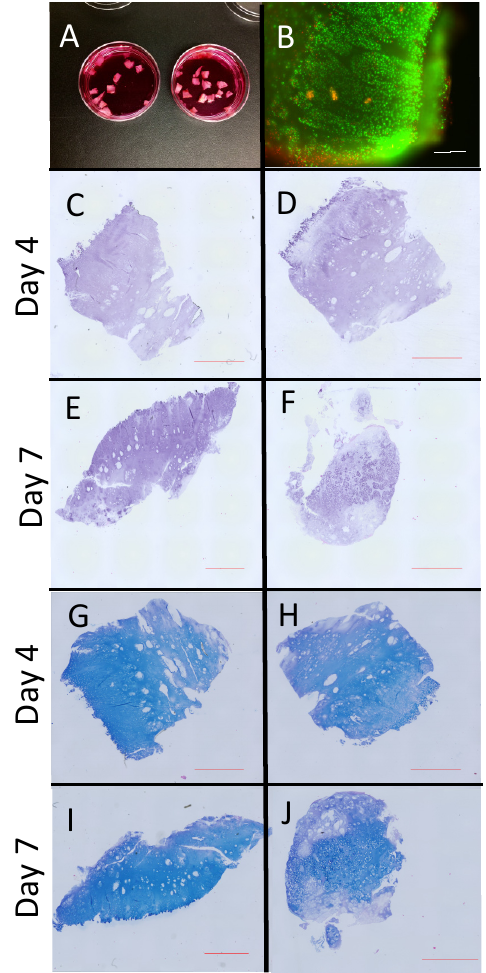
Figure 1. Osteochondroma explant cultures. Cartilaginous portions (cartilage caps) were micro-dissected from human osteochondromas excised at surgery and made into 3–5 mm cubic ( A ) and subjected to explant culture. On the next day, the explants were subjected to Live / dead assay ( B ) or treated with vehicle (0.1% ethanol) ( C , E , G , I ) and 300 nM NRX204647 (D , F , H , J) in in Dulbecco’s Modified Eagle Medium (DMEM) containing 2% charcoal-treated FBS. The explants were fixed with 4% PFA 4 day ( C , D , G , H ) or 7 day ( E , F , I , J ) after treatment, and then stained with hematoxylin-eosin